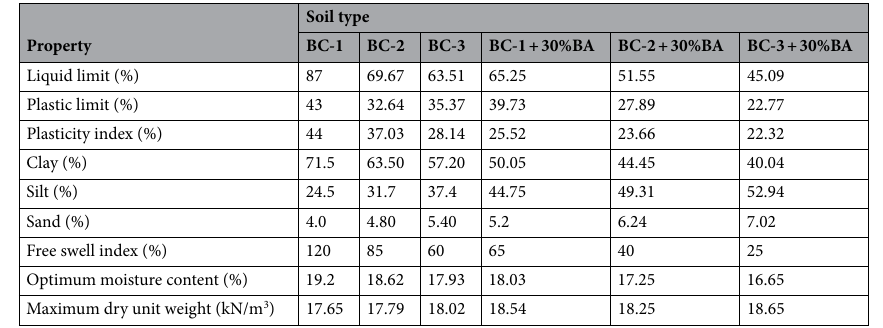
Table 1. Index properties of considered